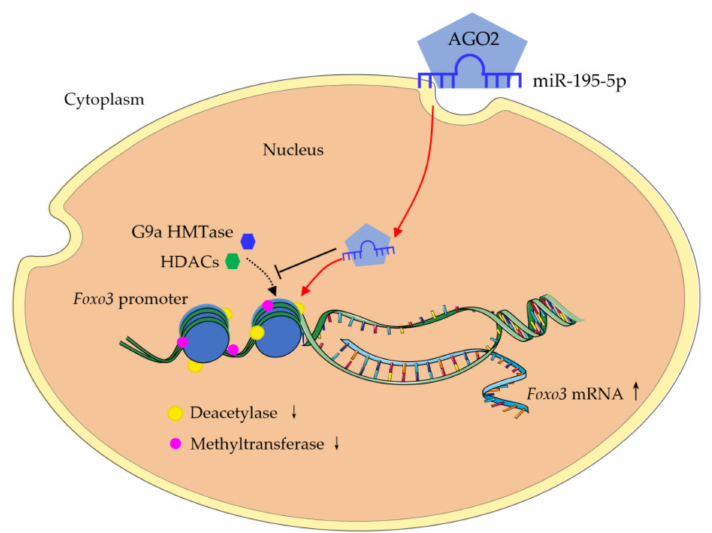
Figure 6. Model of AGO2-miR-195-5p complex assembly in the Foxo3 promoter region, which leads to the epigenetic modifications that regulate the expression of Foxo3 . AGO2: Argonaute 2. G9a HMTase: G9a histone methyltransferase; HDACs: histone deacetylases. ↑ means up-regulation, ↓ means